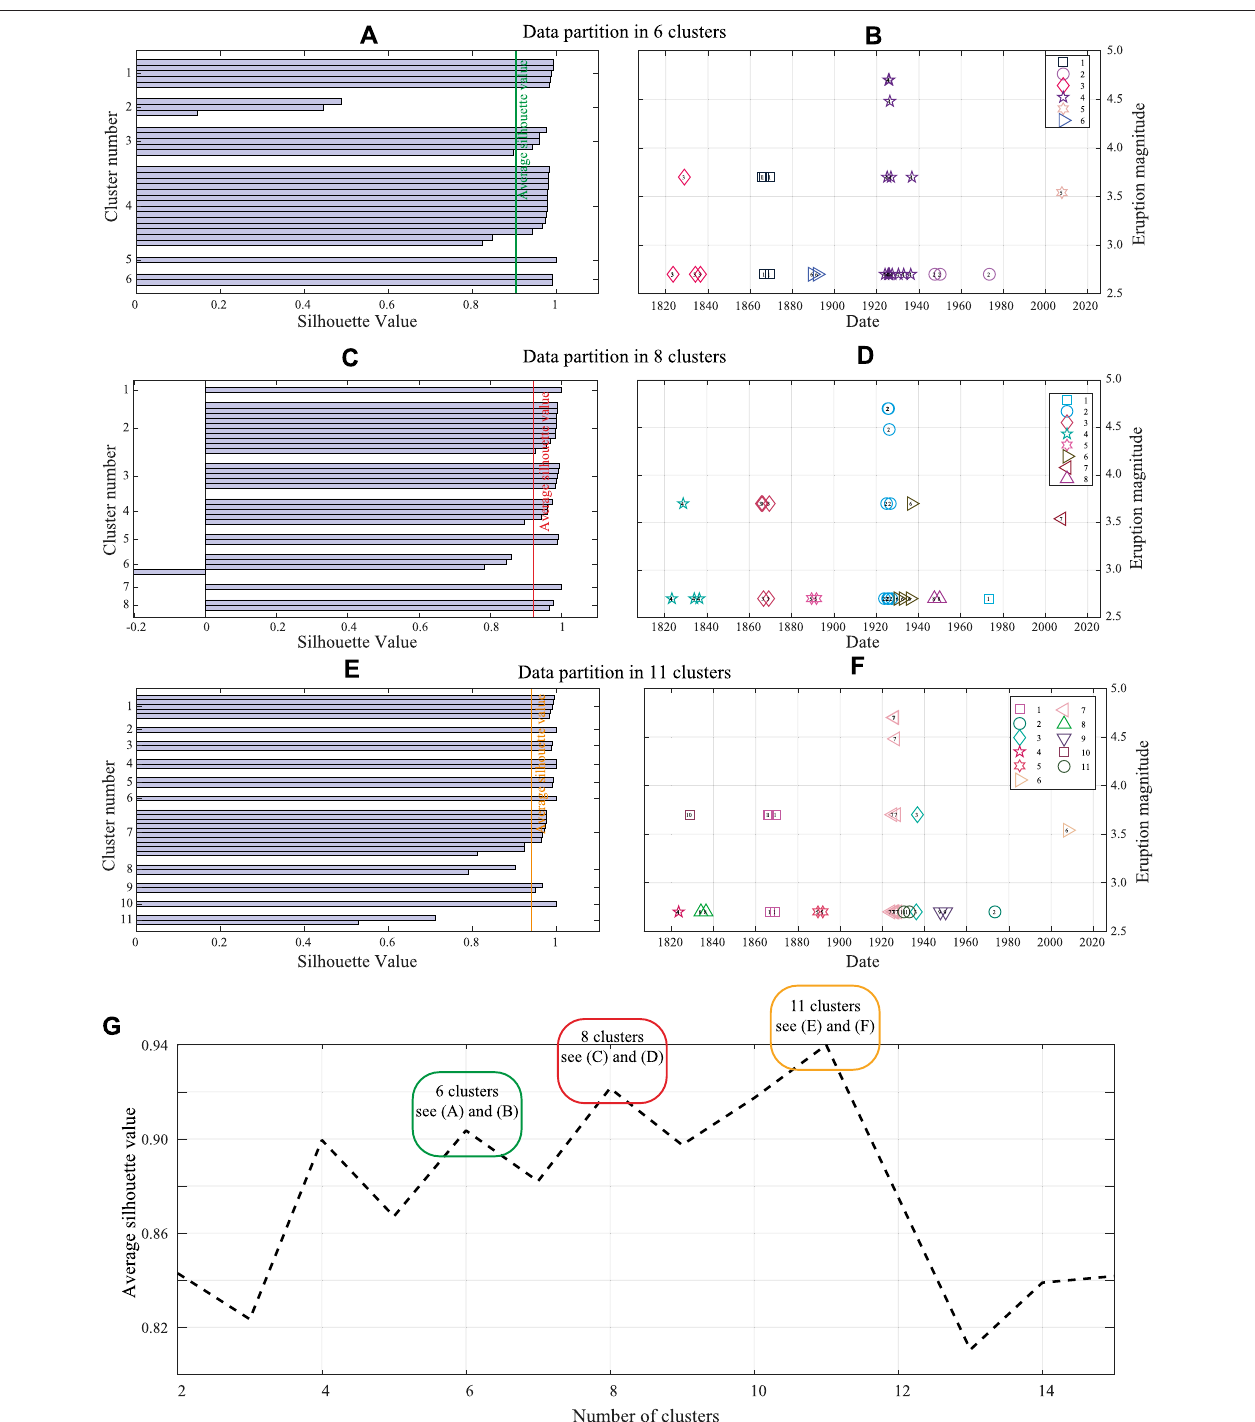
FIGURE6| Leftpanel:plotofthesilhouettecoef fi cient s ( i ) forthepartitionin6 (A) ,8 (C) and11 (E) clusters;verticallinesshowtheaveragesilhouettewidth.Wesee thatthesecondclusterinthecaseofpartitionin6clusters,thesixthinthecaseof8,andthe8thand11thclustersinthecaseof11,arebelowaverage.InpanelC,oneof the silhouette values is negative. Right panels: clusters in grouping in time, for partitions in 6 (B) , 8 (D) and 11 (F) clusters). Panel (G) shows the average silhouette value for different cluster numbers.